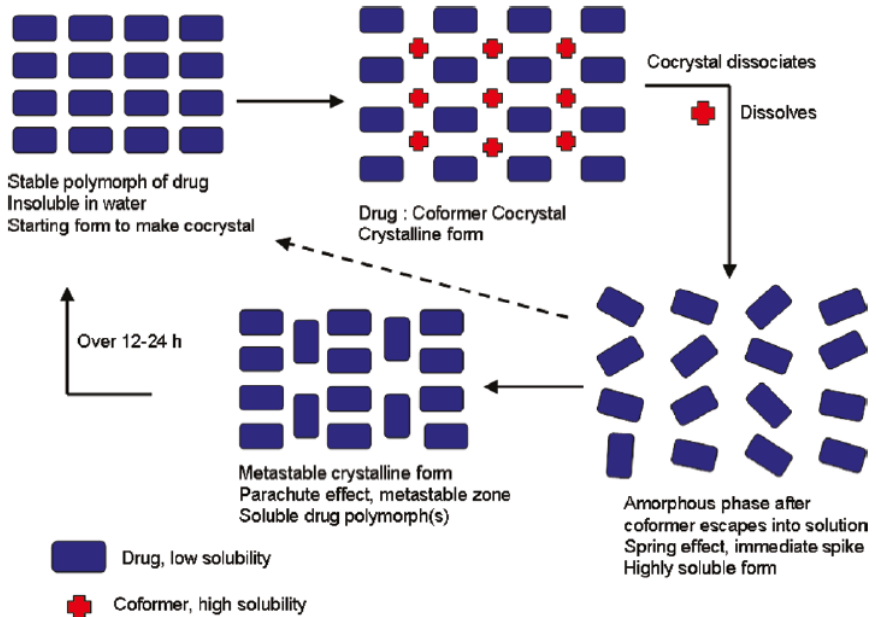
Figure 38. Proposed mechanism for dissolution of pharmaceutical cocrystals [Reprinted from [95] with permission. Copyright 2011 American Chemical Society].